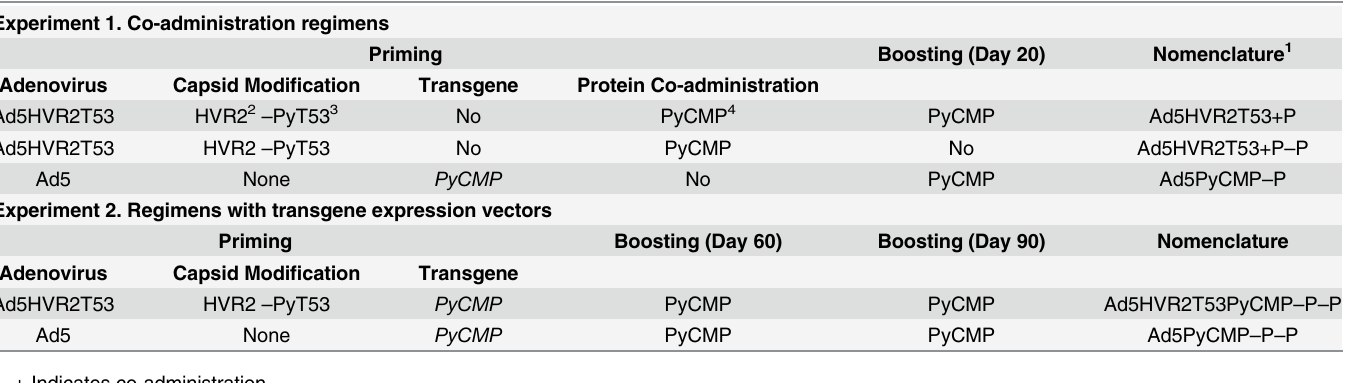
Table 1. Immunization regimens tested with hexon modified